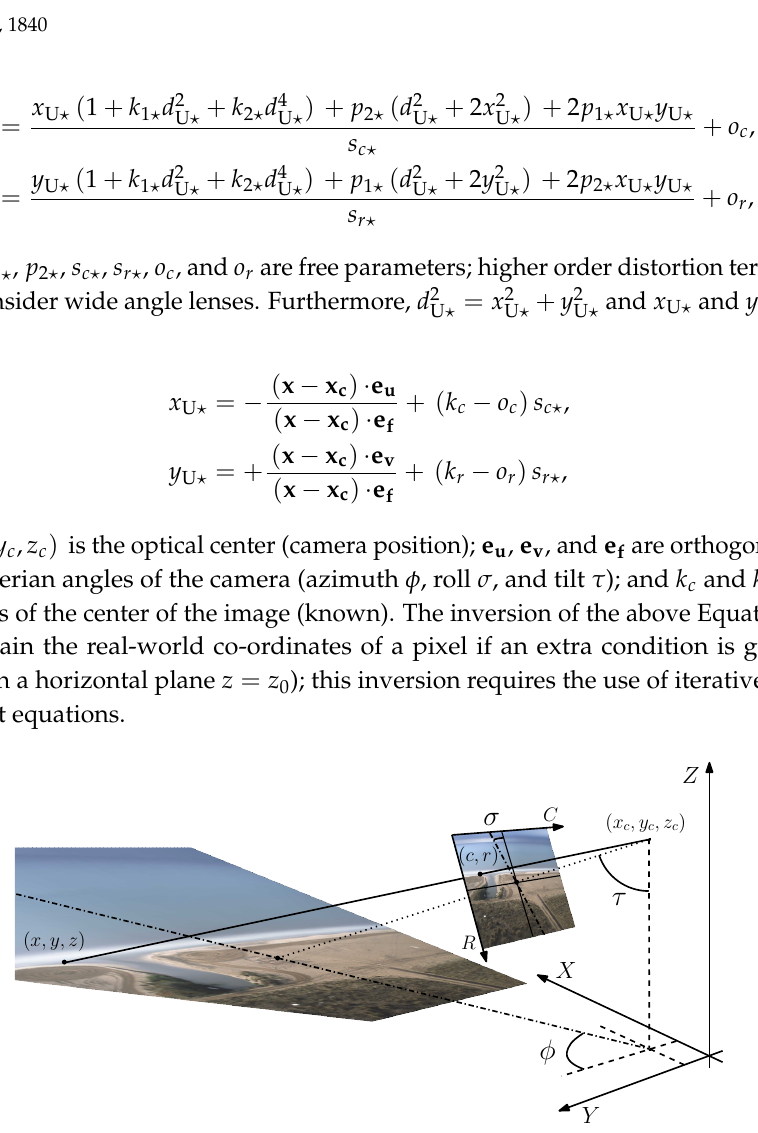
Figure 2. Real-world to pixel transformation: camera position ( x c , y c , z c ) and Eulerian angles ( φ , σ and τ